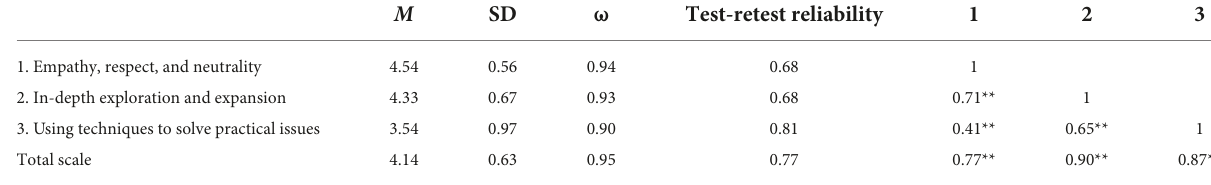
TABLE 4 Reliability and interdimensional correlations of HTAIS.